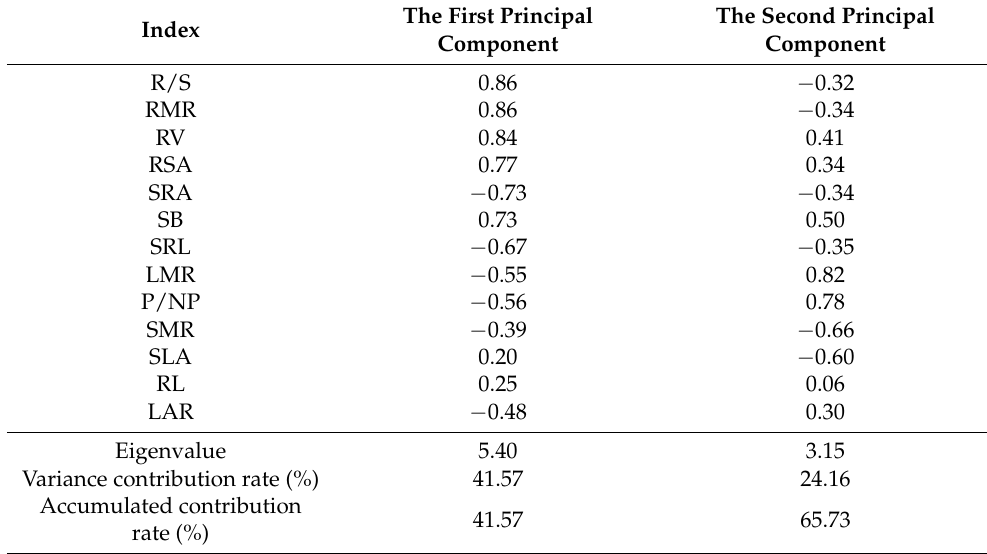
Table A1. Coefficient, eigenvalue, variance contribution rate, and the accumulated